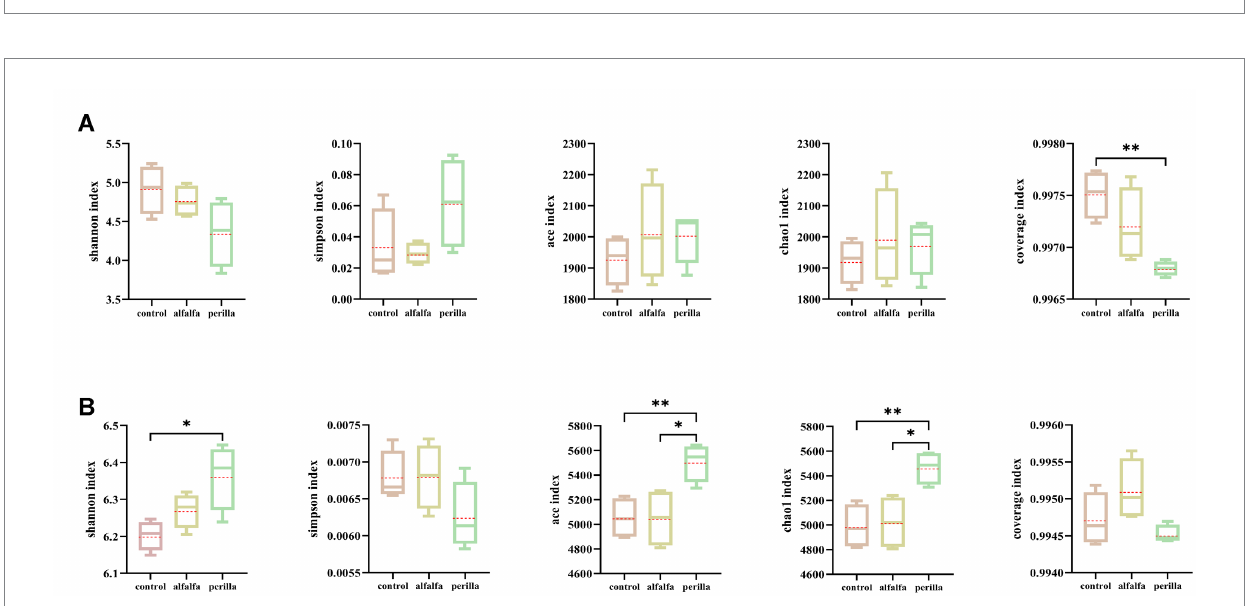
FIGURE 2 Enzyme activities of the soil in different treatments. Control, no treatment; Alfalfa, alfalfa cultivation; perilla, perilla cultivation. (A) URE, urease; (B) ACP, acid phosphatase; (C) SUC, sucrase; (D) CAT, catalase; (E) LAC, laccase. Error represents the standard deviation; different letters indicate a significant difference at the p < 0.05